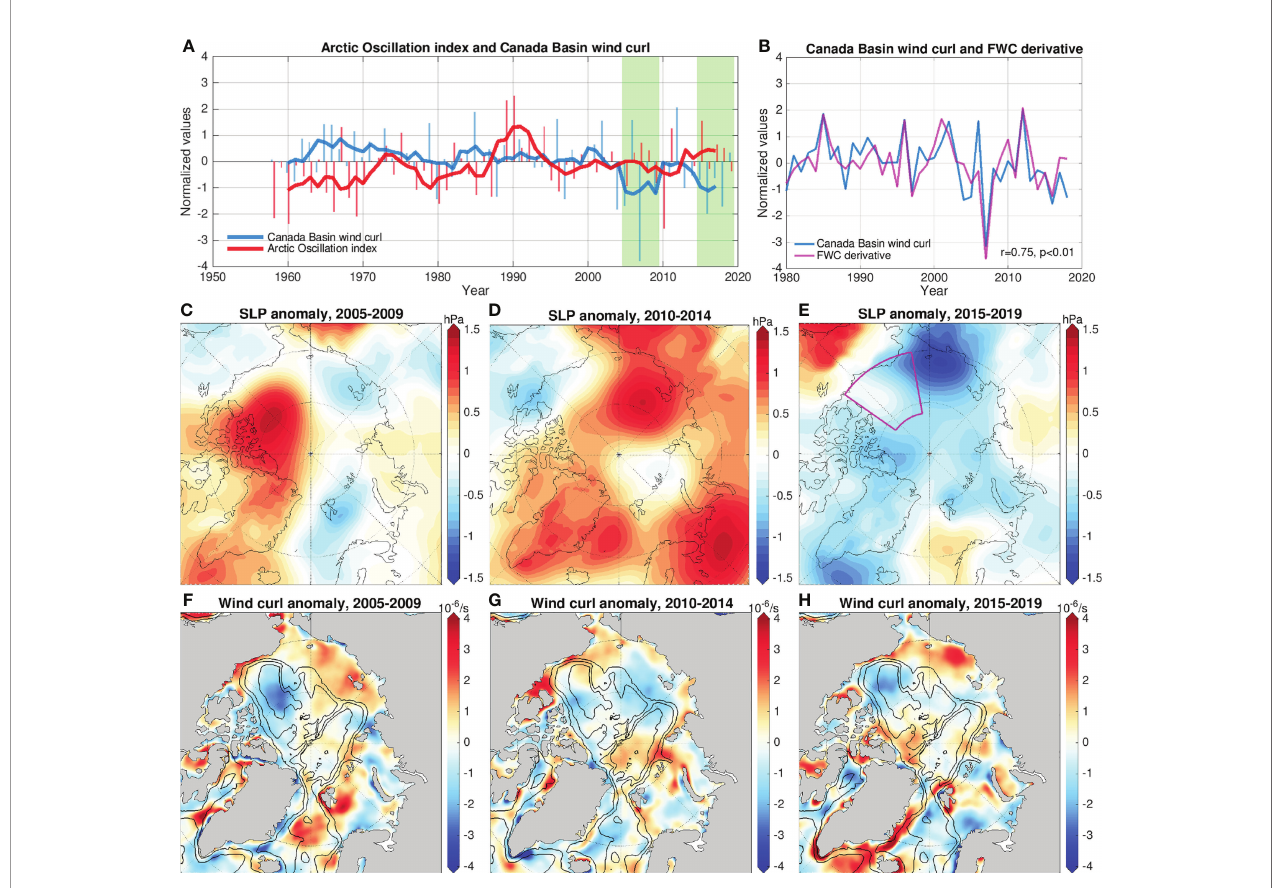
FIGURE 3 | Atmospheric circulation conditions in the 2000s and 2010s. (A) Normalized Arctic Oscillation index (red) and wind curl averaged over the Canada Basin (CB, blue). Annual means are shown with bars and fi ve years running means are shown with solid lines. (B) Normalized wind curl averaged over the CB (blue) and the inversed derivative of freshwater content (FWC) in the CB, indicating that the wind curl is a good indicator of CB FWC changes. (C – E) Sea level pressure (SLP) anomaly relative to the 1980 – 2019 mean for (C) 2005 – 2009, (D) 2010 – 2014 and (E) 2015 – 2019. (F – H) Wind curl anomaly in the three corresponding periods. The two periods with green background in (A) correspond to (C, F) and (E, H) respectively. In both the periods, the CB is featured with large negative wind curl (A) , although the SLP anomalies are very different. The wind curl in (A) is averaged in the region denoted by the magenta box in (E)